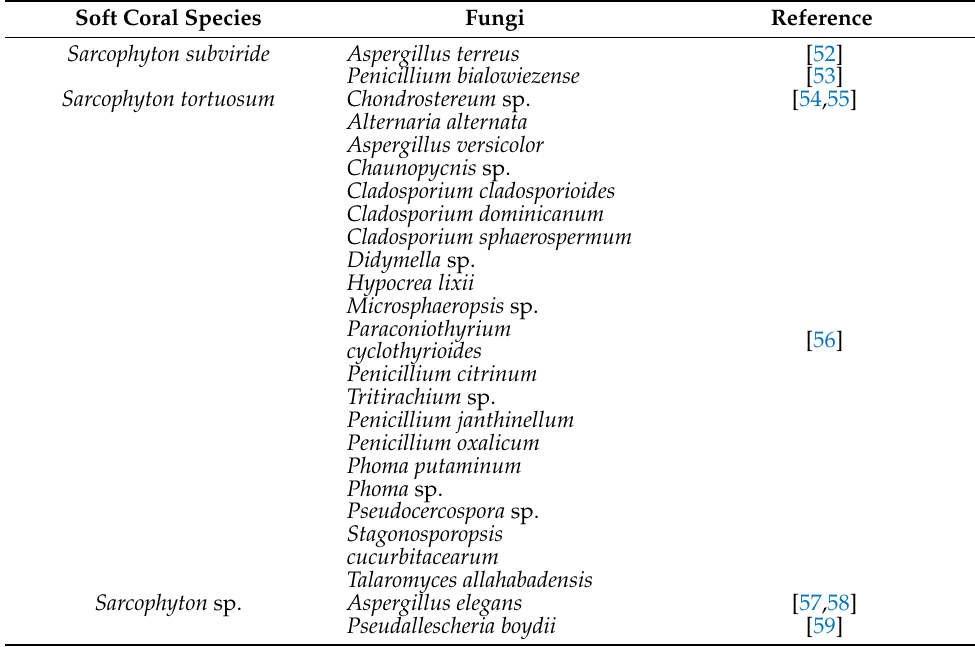
Table 2. Soft coral genus Sarcophyton and its associated marine